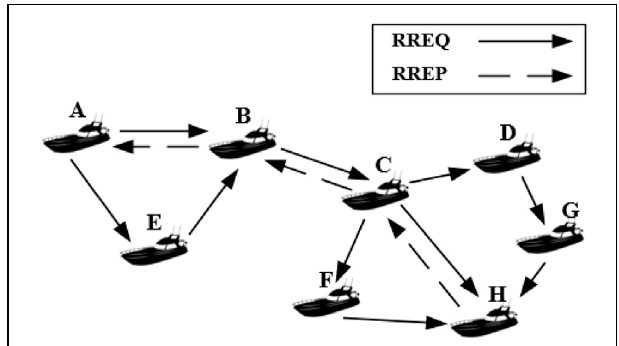
FIGURE 4 | Route establishment